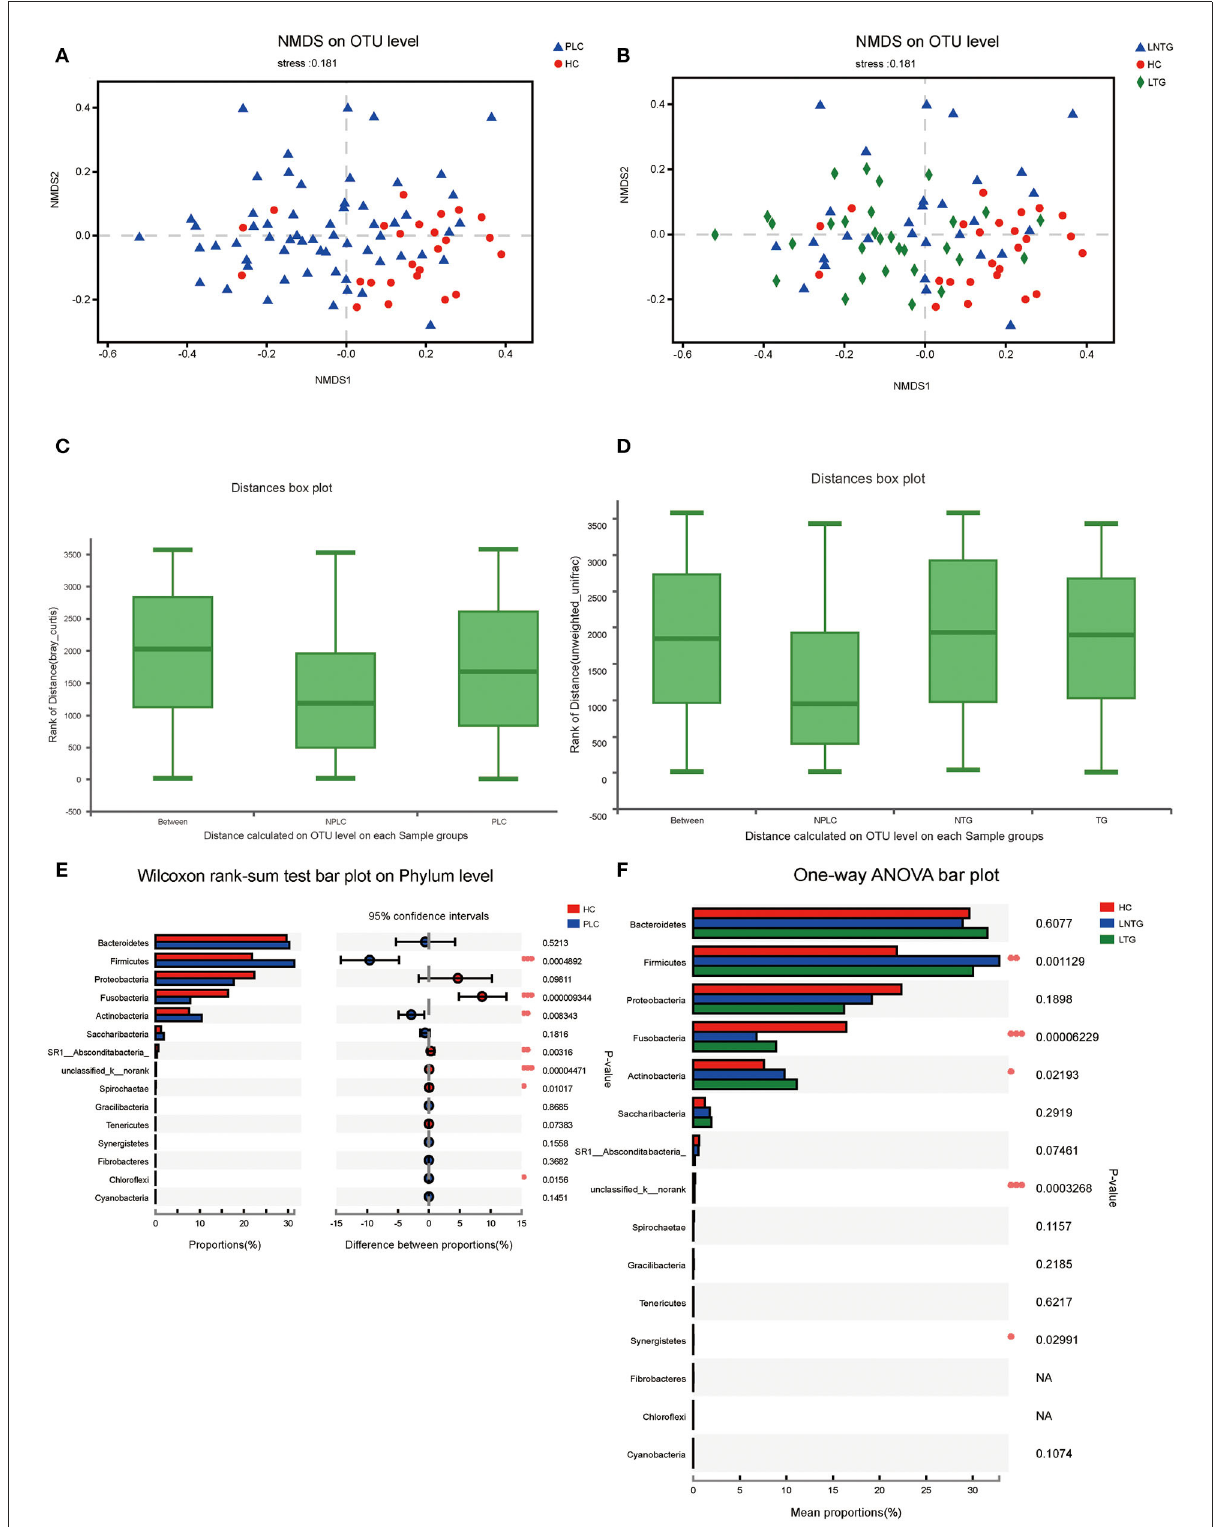
FIGURE3 The tongue-coating microbial diversities. (A,B) Beta diversity of the tongue-coating microbiota was analyzed using non-metric multidimensional scaling (NMDS) on a Brays–Curtis distance matrix between the two groups (A) and among the three groups (B) . (C,D) Box diagram of the tongue-coating microbiota was analyzed using the ANOSIM test on a Bray–Curtis distance matrix between the two groups (C) and among the three groups (D) . (E,F) Comparison of the microbiome on phylum level of the two groups (E) and among the three groups (F)